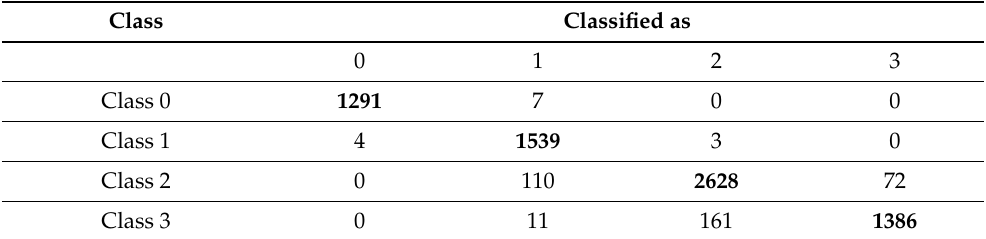
Table 11. The classification confusion matrix of the method M 16 × 12 E − d 2 on the test set. Class